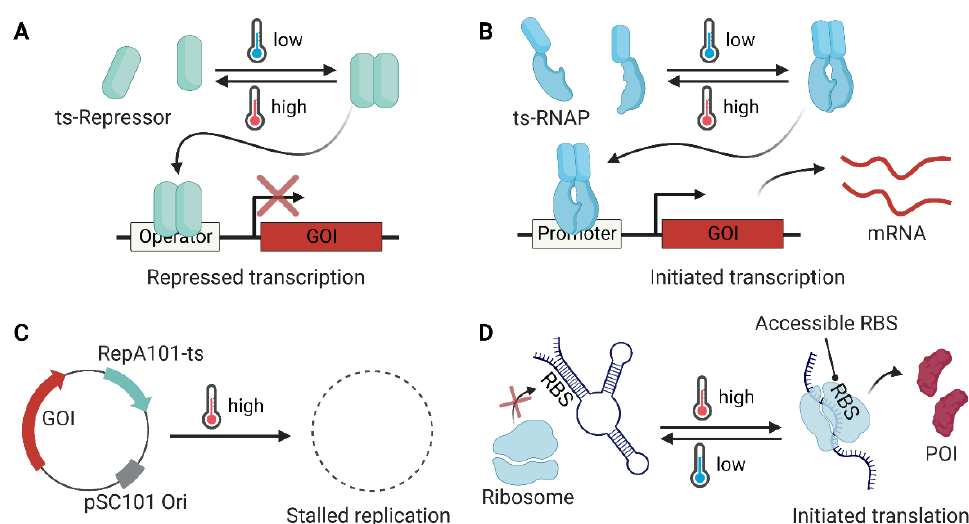
Figure 2. Temperature-sensitive modules utilized in bacterial engineering. ( A ) A temperature-sensitive (ts) dimeric repressor (e.g., cI857 and TlpA) forms a dimer and binds to the operator, thereby inhibiting gene expression at low temperatures. ( B ) A temperature-sensitive dimer module (e.g., the coiled-coil domain of TlpA) can be fused to split RNA polymerase (RNAP) to generate a temperature-sensitive transcription system. ( C ) A temperature-sensitive replication system restricts the replication of a plasmid that contains the genes of interest (GOI) at the defined temperature. ( D ) An RNA thermometer can be designed to have a buried ribosome binding site (RBS) by forming a stable hairpin structure at low temperatures (<30 °C) to inhibit translation, whereas the RBS is exposed at high temperatures (>37 °C) for ribosome entry and the translation of the GOI to generate the protein of interest (POI).